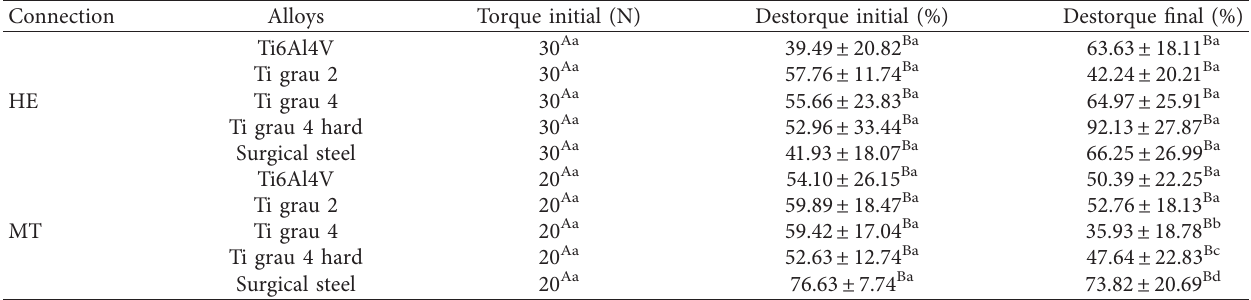
Table 2: Means and standard deviation of torque maintenance (destorque) considering HE and MTconnections and their respective alloys in the periods premechanical (initial destorque) and postmechanical cycling (final